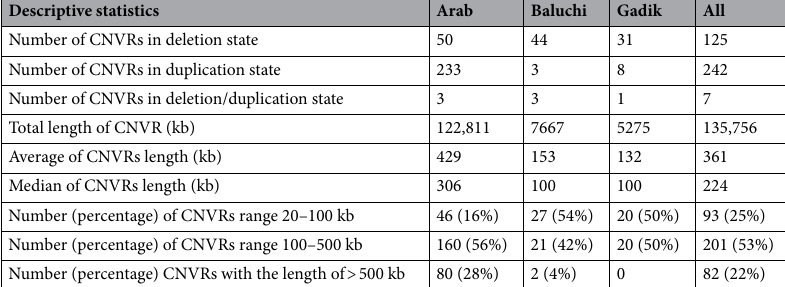
Table 2. Summary of CNVRs identified in Afghan sheep breeds.